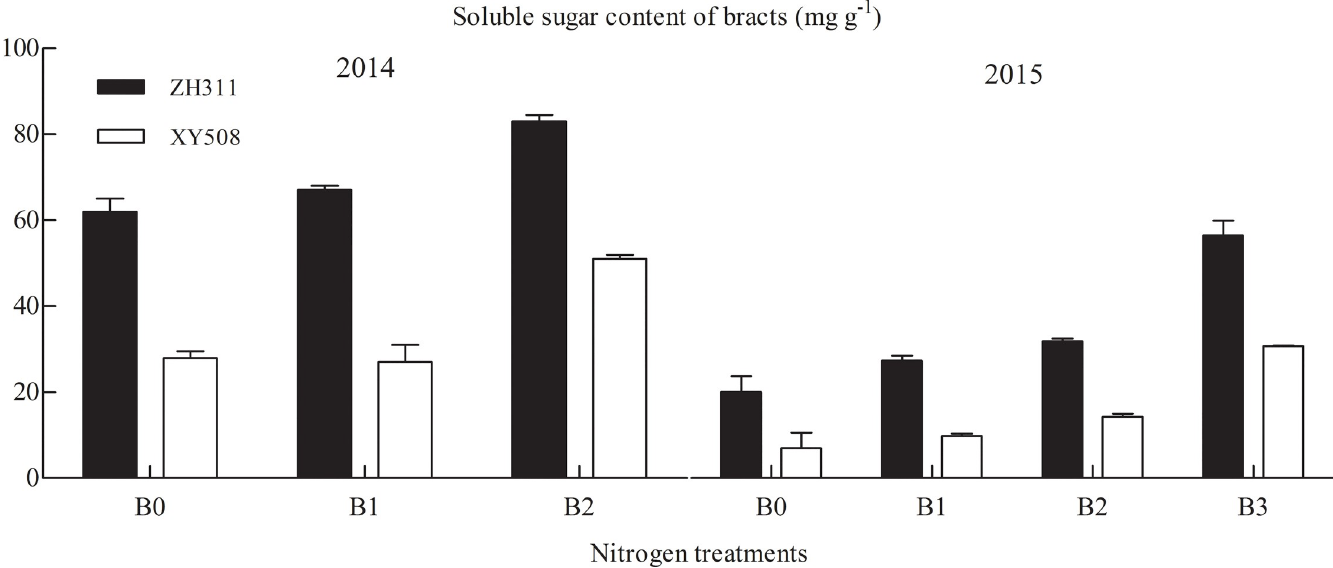
Fig 4. Soluble sugar content in the bracts at maturity under different nitrogen treatments. Note: B0, 0 kg � ha -1 ; B1, 150 kg � ha -1 ; B2, 300 kg � ha -1 , and B3, 450 kg � ha -1 .